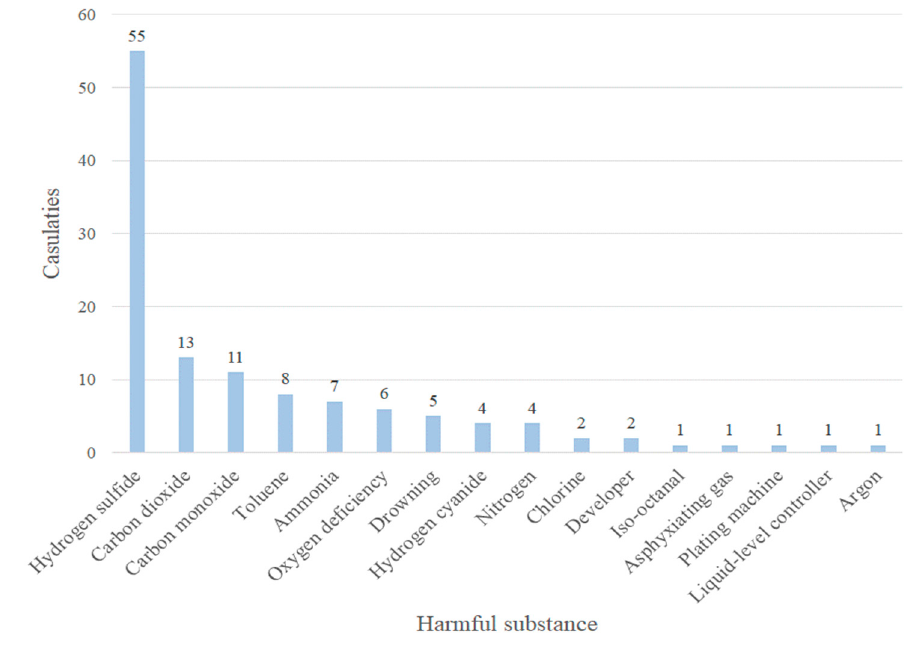
Figure 2. Classification statistics for media and casualties of confined space accidents in Taiwan from 2008 to 2018.